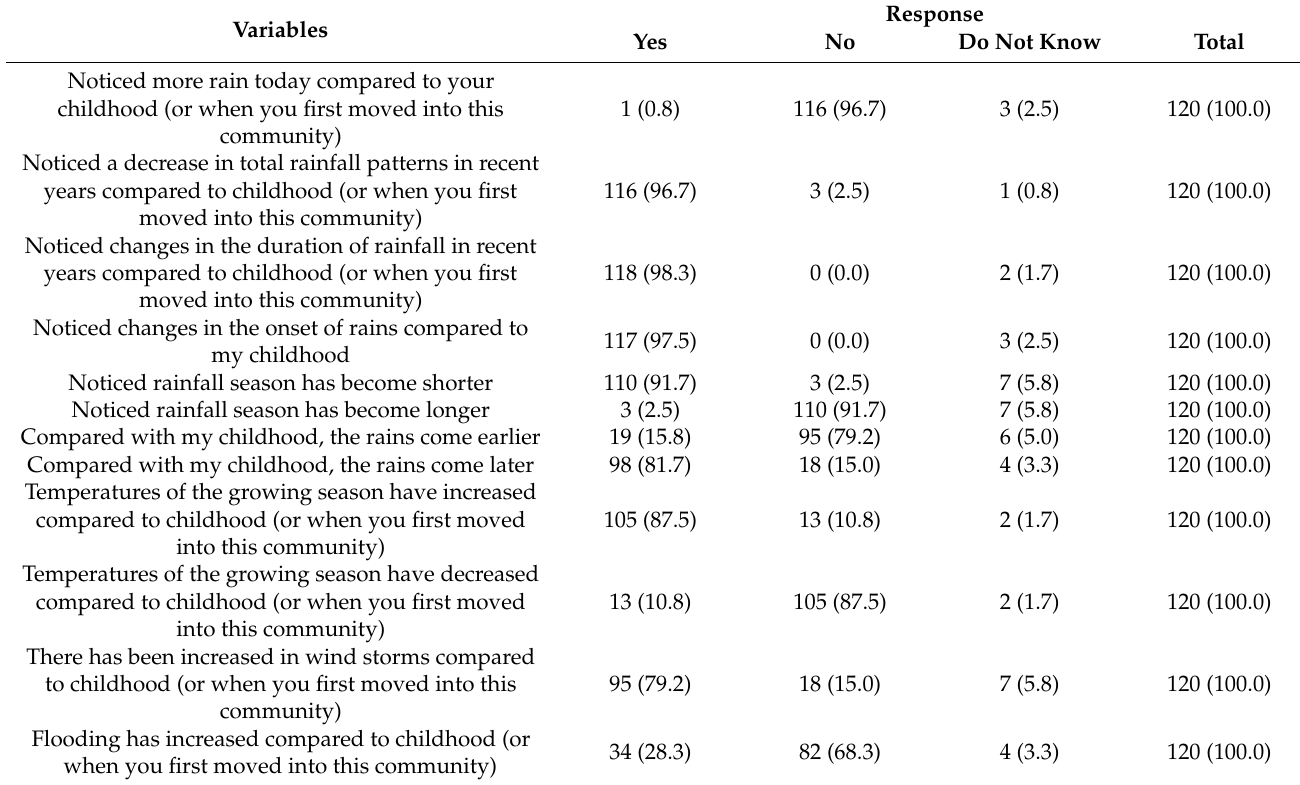
Table 1. Farmers’ perception of climate variability in Ejura-Sekeyedumase